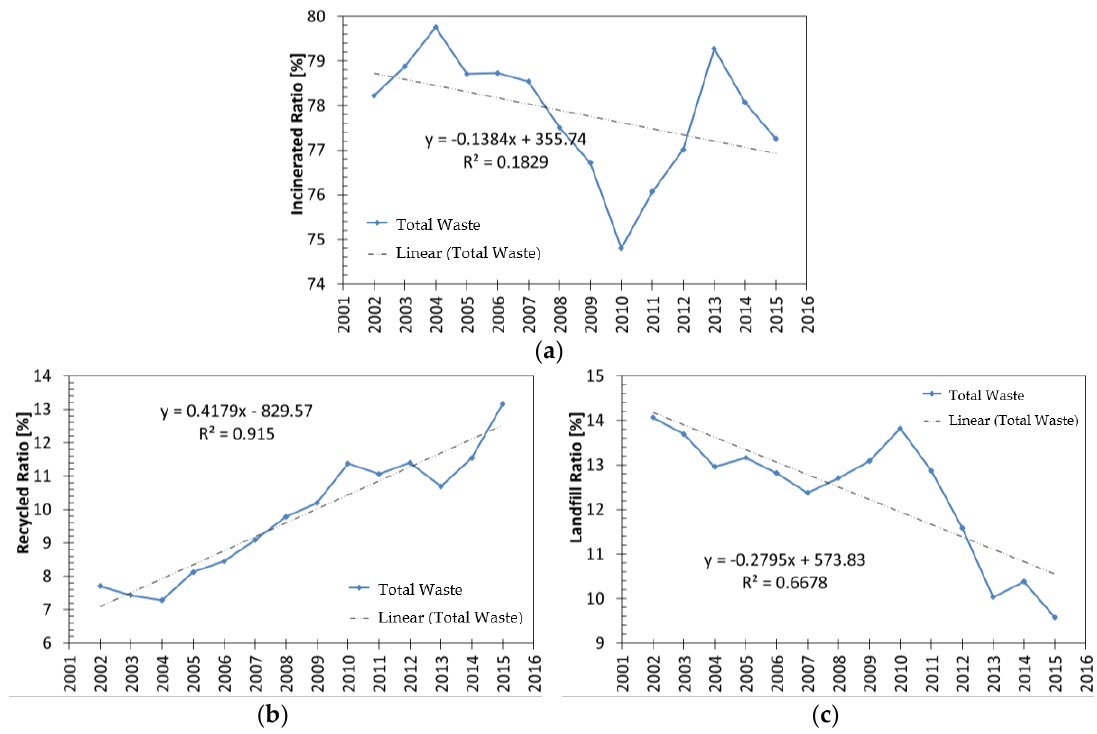
Figure 8. Waste categories as a percentage of total waste at Kansai International Airport during 2002–2015: ( a ) incinerated; ( b ) recycled; and ( c ) landfill wastes. Note: solid blue line represents the annual trends in the incinerated, recycled and landfill wastes, the dash lines show the linear trend in these wastes. Source: Data derived from [60,66].